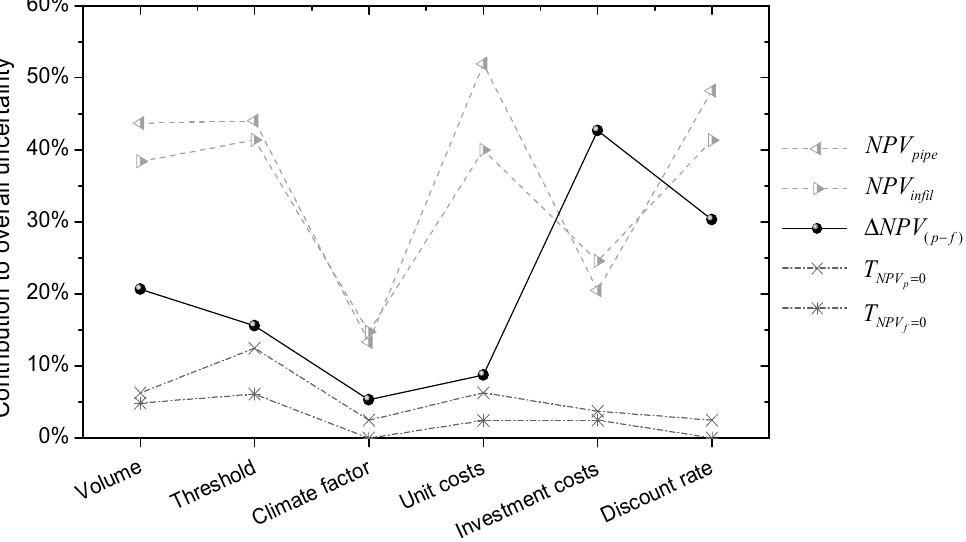
Figure 8. Relative contribution of input variables to the overall uncertainty of assessed outcomes.